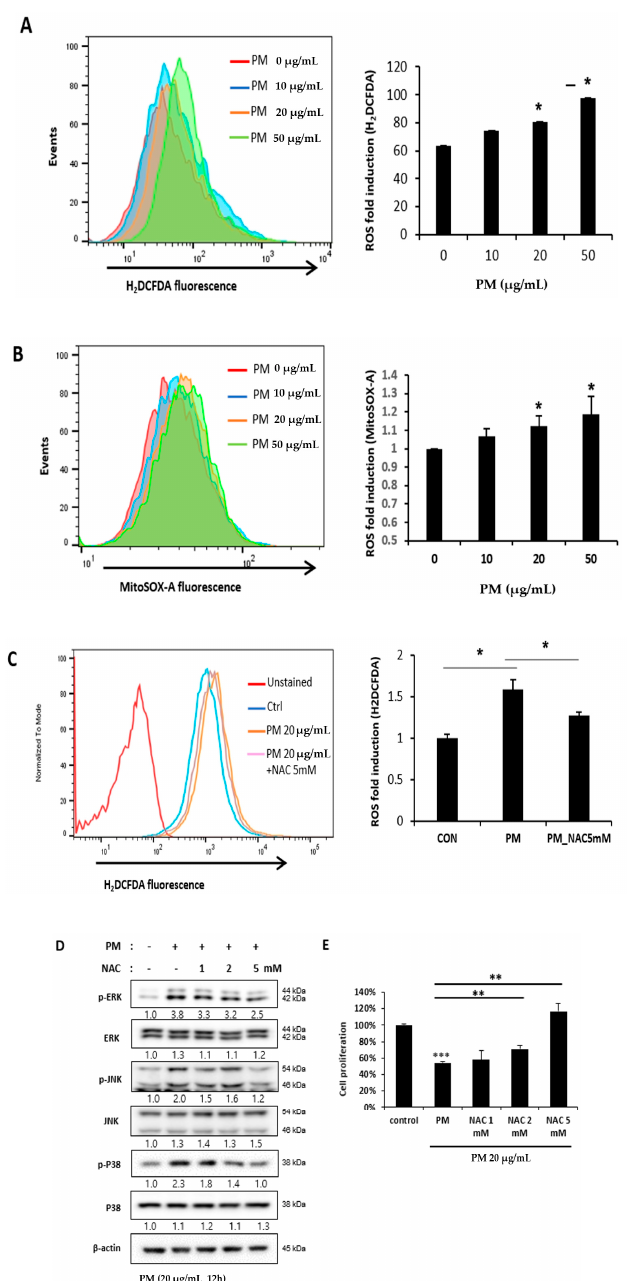
Figure 4. PM-induced ROS activates the MAPK pathway. ( A , B ) Cytoplasmic ROS and mitochondrial ROS expression after the PM treatment was evaluated. Both the cytoplasmic and mitochondrial ROS increased significantly with the PM concentration. Cells were treated with various concentrations of PM (0–50 µ g / mL) for 12 h. ( C ) The increased ROS expression was decreased significantly by the ROS scavenger NAC (5 mM). ( D ) The increased expression of the protein associated with the activation of the MAPK signaling pathway was reduced by NAC (5 mM). ( E ) Cell proliferation, which was reduced after the PM treatment, recovered significantly in proportion to the concentration of NAC (0–5 mM). Cells were treated with PM (20 µ g / mL) for 12 h. * p < 0.05, ** p < 0.01, *** p <